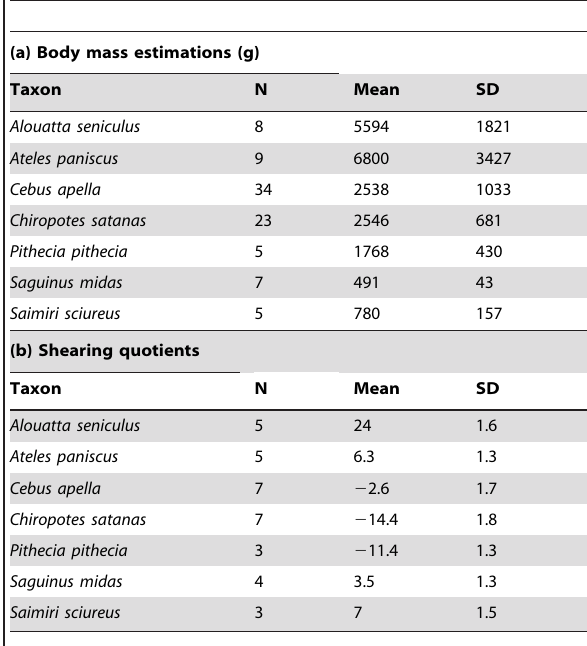
Table 4. (a) Mean and standard deviation of body mass for each species (Values are in